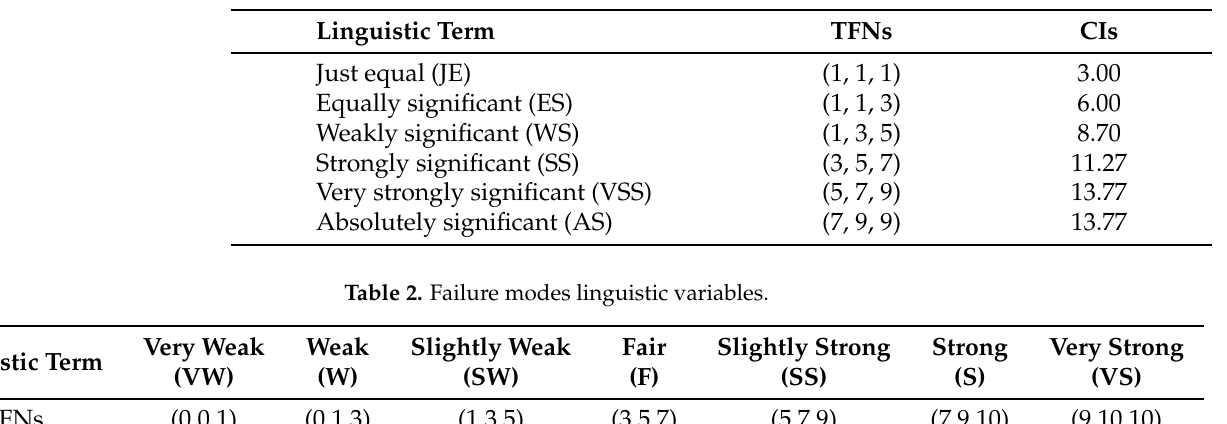
Figure 1. Offered approach flow chart. Table 1. The required linguistic terms and CIs for the weights of triple factors.